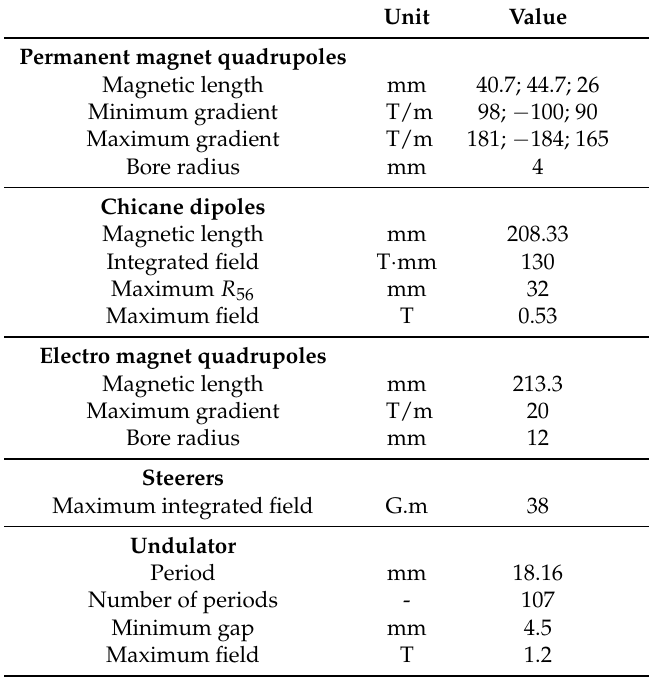
Table 2. COXINEL magnets relevant parameters. The three values for PMQs are for each PMQ of the triplet in the beam propagation